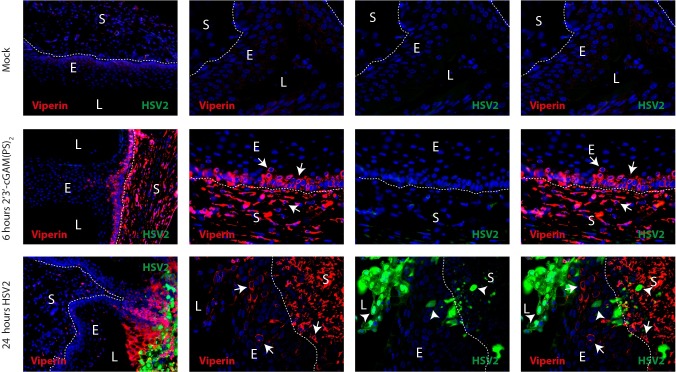
HSV2 and STING agonists induce antiviral genes in vaginal epithelium.Mice were injected i.p. with 2’3’-cGAM(PS)2 (125 μg/mouse) or infected with HSV2 (6.7×104 p.f.u.). Tissues were isolated from mice 6 h and 24 h after CDN stimulation and HSV2 infection, respectively. Paraffin sections of the vaginal tissues were stained for viperin (red) and HSV2 (green). DAPI (blue) marks the nuclei and the dotted white lines mark basal membrane between the epithelium and stroma. White arrows highlight examples of viperin positive cells, and arrowheads mark examples of HSV2-infected cells. L = lumen, E = epithelium, S = stroma. n = 3. One representative picture is shown for each staining and treatment group.